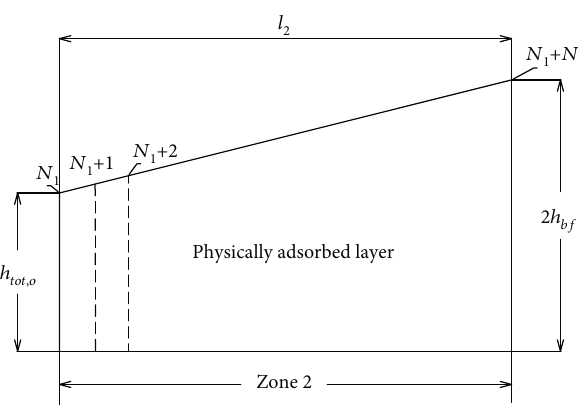
Figure 4: The discretized points in the zone 2 of the inlet